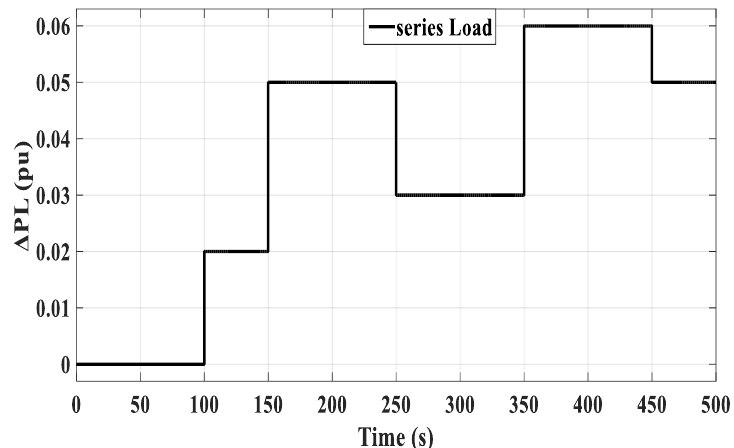
Mathematics 2022 , 10 , x FOR PEER REVIEW Figure 16. The form of the applied series SLP. Figure 16. The form of the applied series SLP.